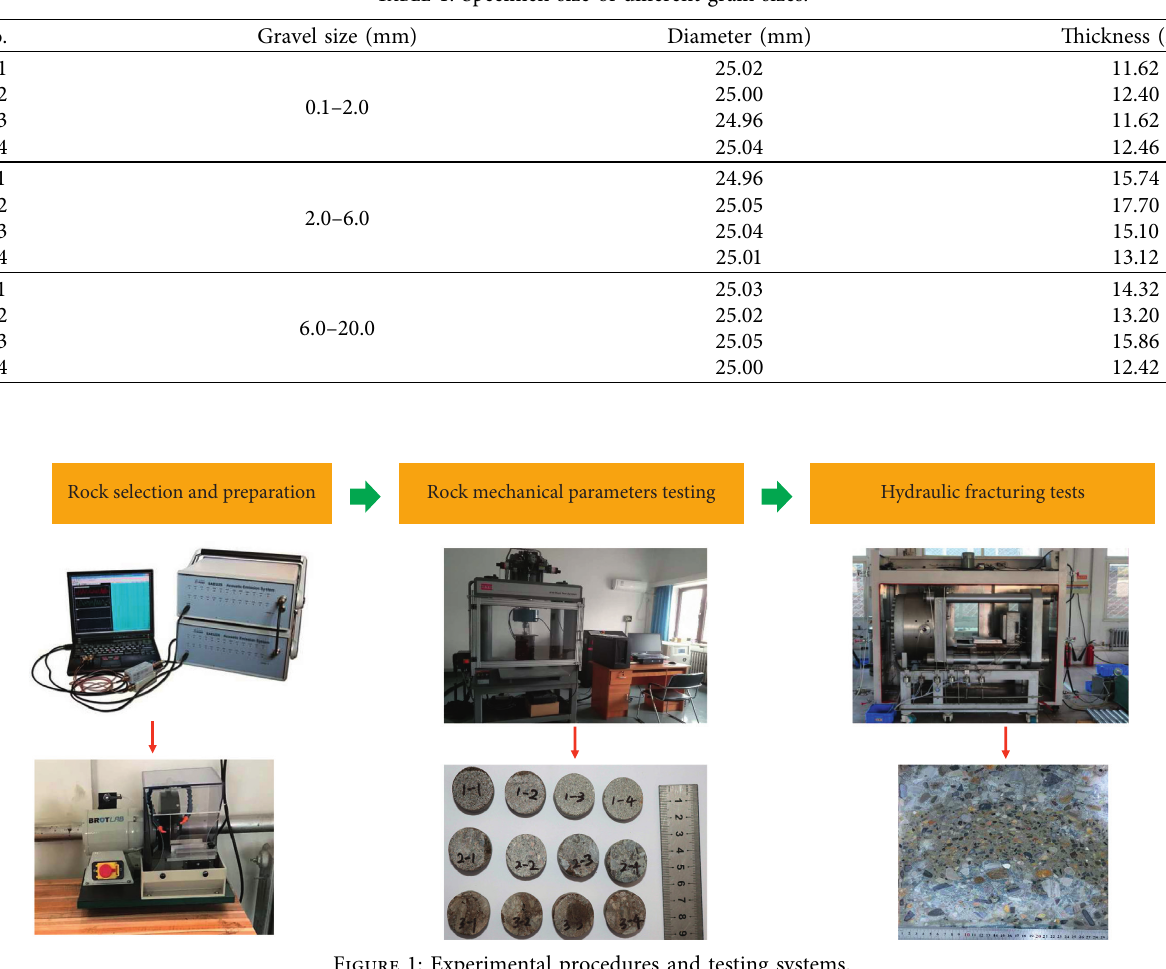
Table 1: Specimen size of different grain